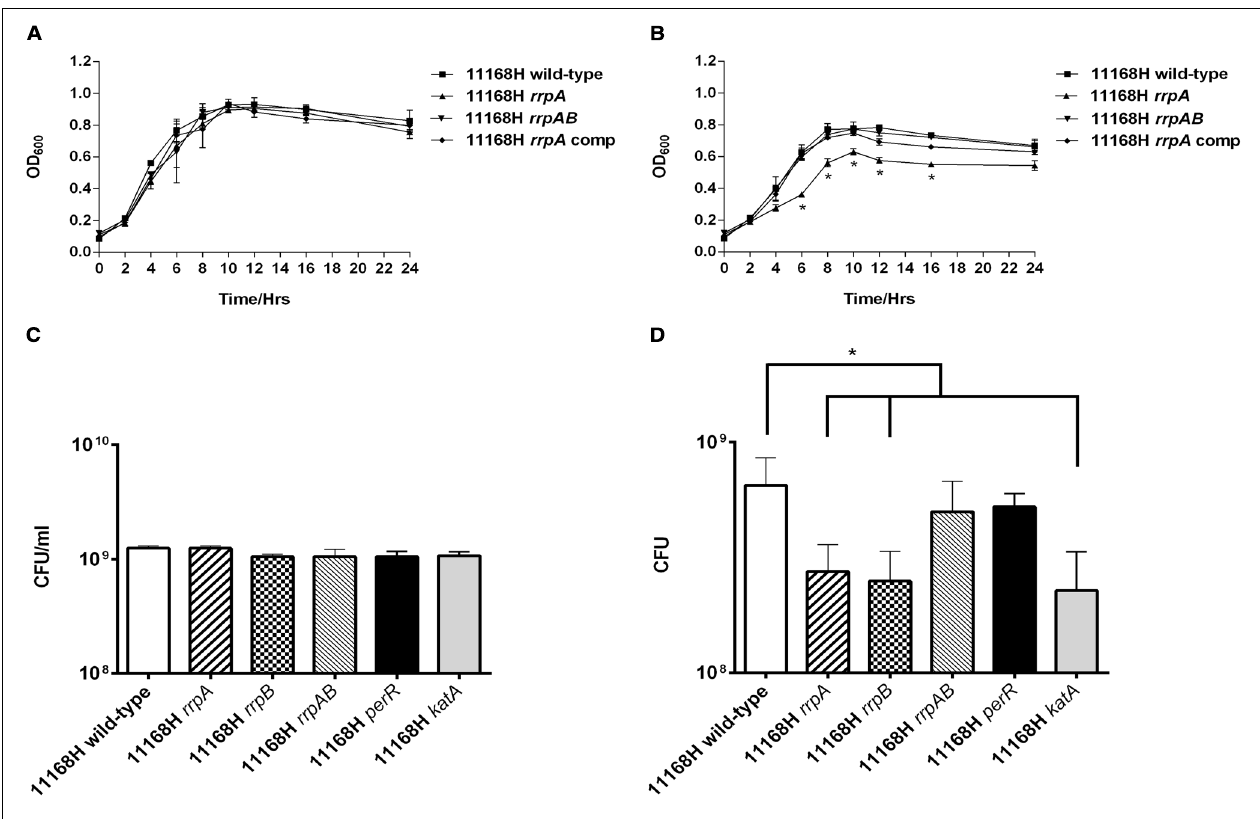
FIGURE 6 | Growth curves for C. jejuni 11168H wild-type strain, rrpA mutant, rrpA complement strain ( rrpA comp) and rrpAB mutant grown under either microaerobic (A) or aerobic conditions (B) at 37°C (with shaking at 75 rpm) in Brucella broth with bacterial growth